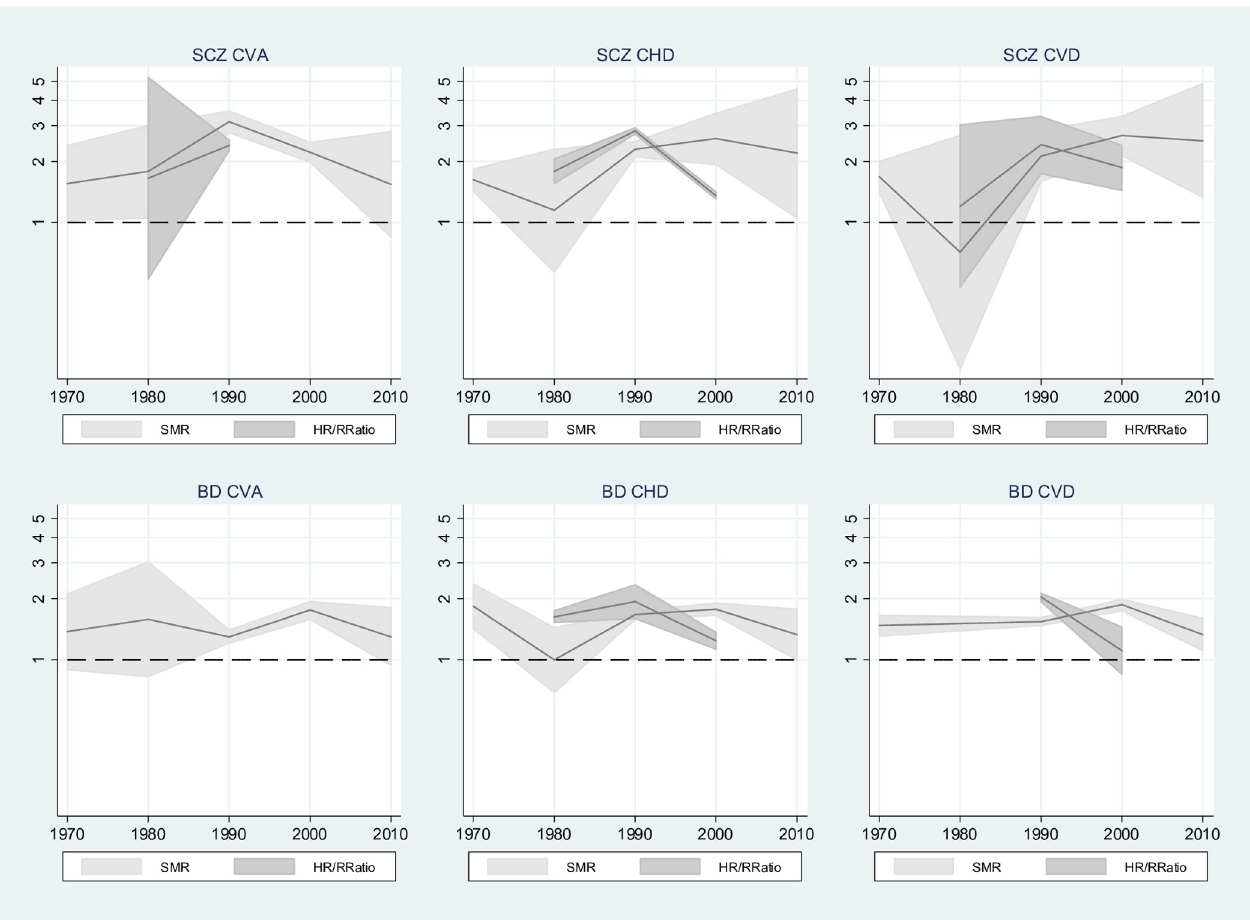
Fig 4. Trend in risk of CVD mortality for SMI compared with control participants, by median decade. BD, bipolar disorder; CHD, coronary heart disease; CI, confidence interval; CVA, cerebrovascular accident; CVD, all circulatory disease; HR, hazard ratio; RRatio, rate ratio; SMI, severe mental illness; SMR, standardised mortality ratio; SCZ, schizophrenia. The year 1970 includes studies with median between 1950 and 1970. y-Axes show estimated risks on log scale, and shaded areas show 95% CIs for risk estimates.